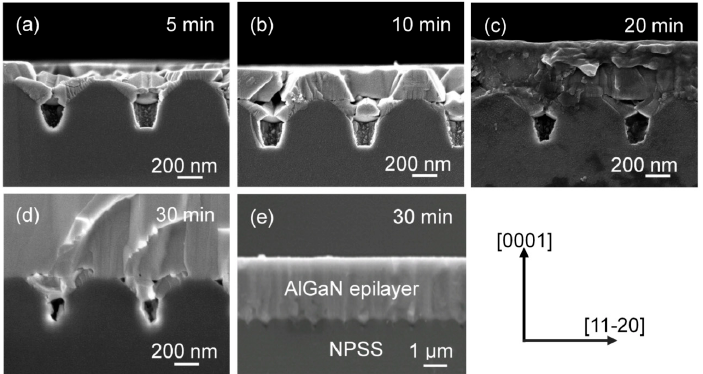
Figure 4. Cross-sectional SEM images of the AlGaN epilayers on NPSSs for various growth times (( a – d ) 5, 10, 20, and 30 min); ( e ) are micrographs of the same 3- μ m-thick cross-sectional AlGaN-on-NPSS sample (30 min) with different magnifications.